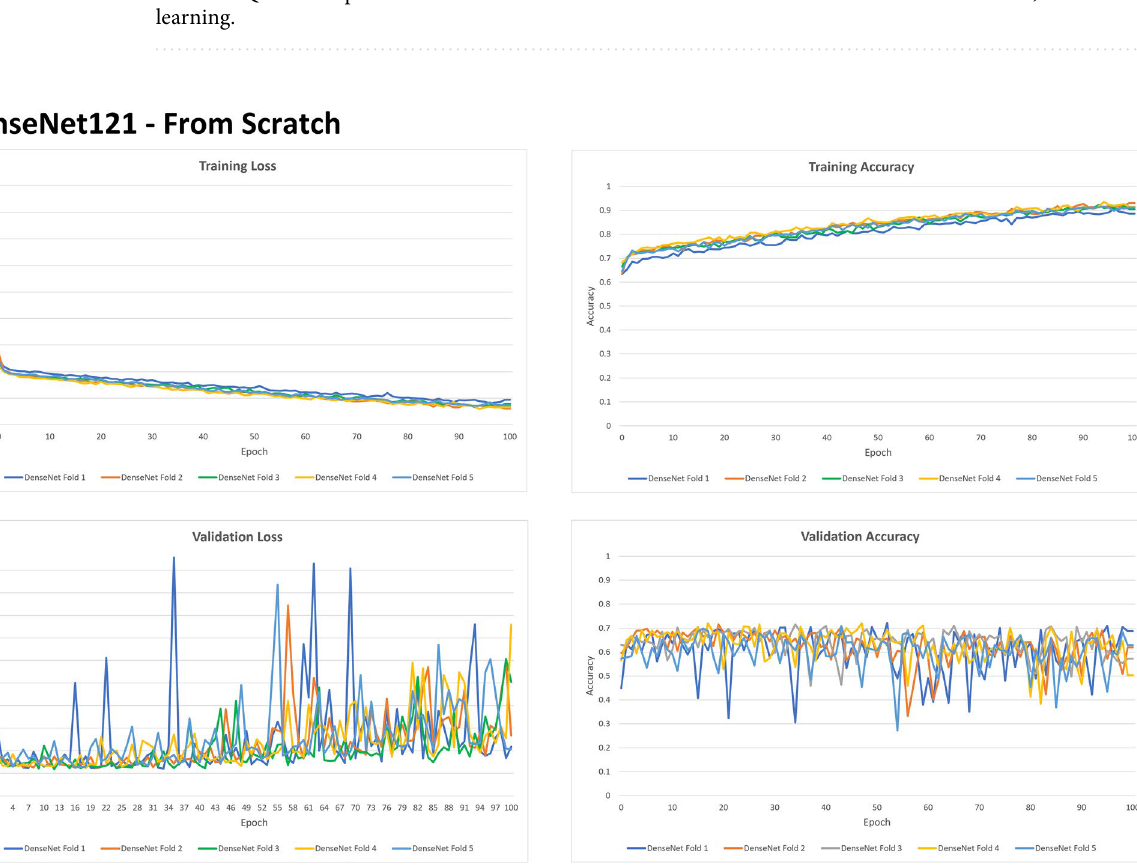
Figure 2. Graphs representing the loss and evolutionary accuracy of the training process and learning validation with From Scratch (FS) architecture in